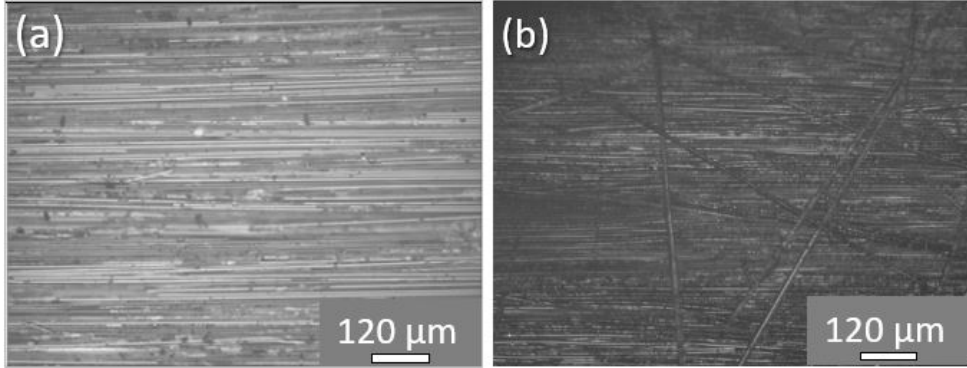
Figure 5. Representative optical microscopy (OM) images from the fractured surface of ( a ) a reference and ( b ) a representative modified CFRP, respectively.